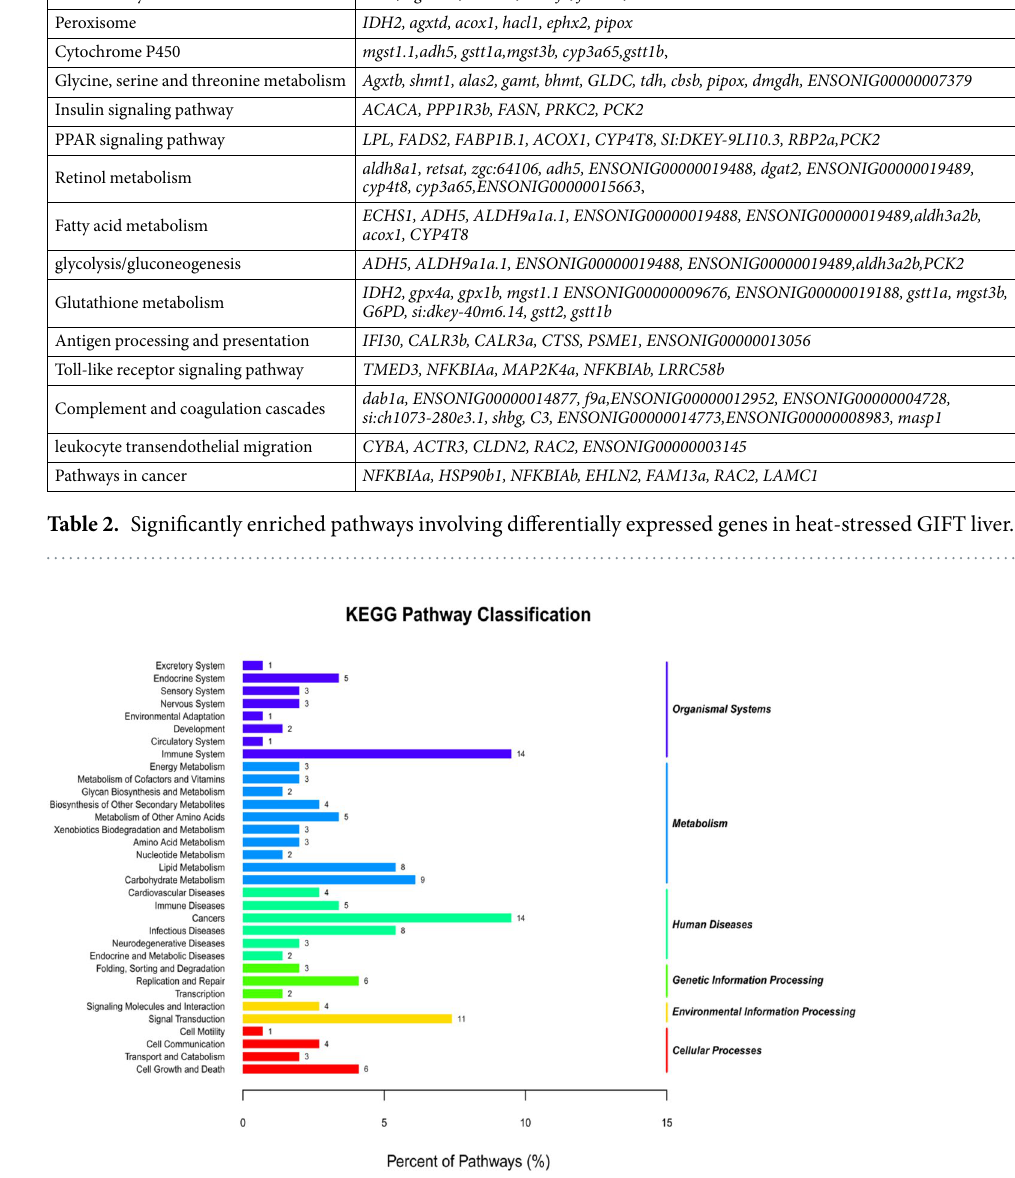
Figure 5. Classification of the enriched KEGG pathways for the negatively correlated miRNA–mRNA pairs of GIFT exposed to heat stress. Negative correlation is defined as having opposite expression patterns between miRNAs and their target mRNAs. The 1525 negatively correlated miRNA–mRNA pairs were associated with 33 KEGG